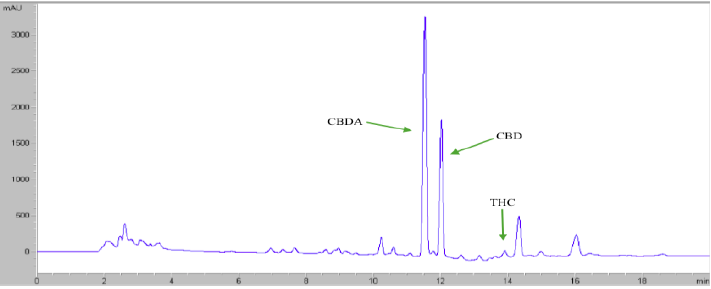
Figure 4. High-performance liquid chromatography (HPLC) analysis of a pre decarboxylation hemp extract. ( x -axis: time in minutes; y -axis: mAU).